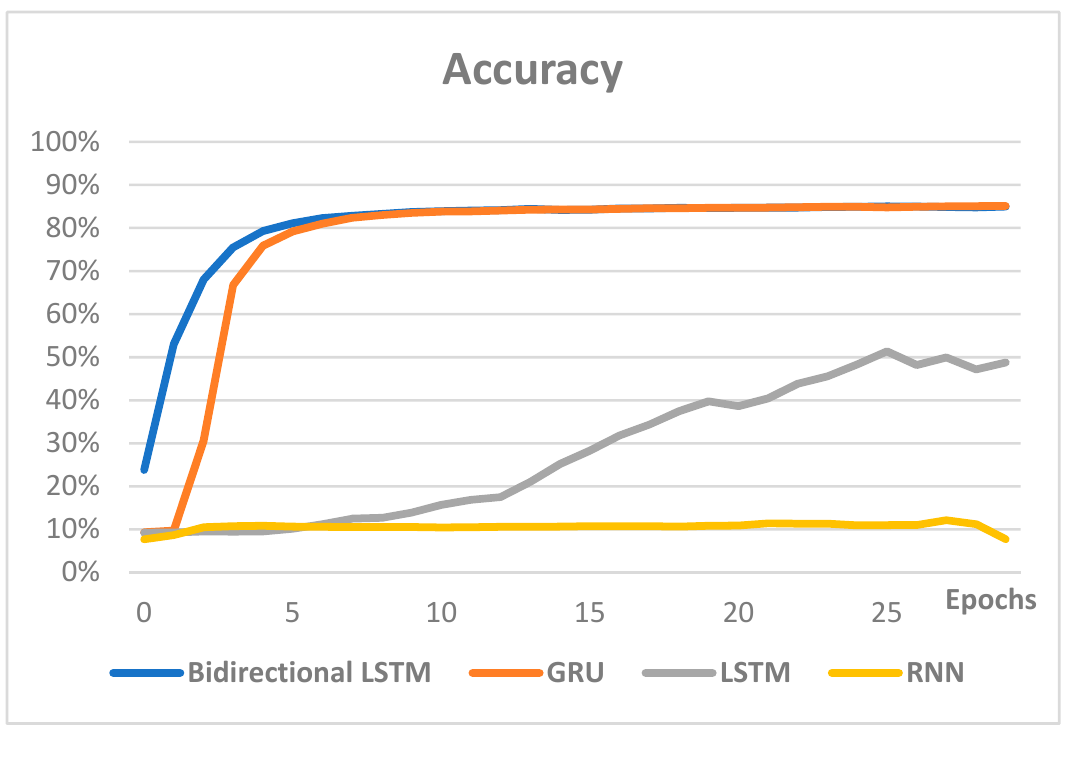
Figure 9. Accuracy comparison of the RNN-based models.